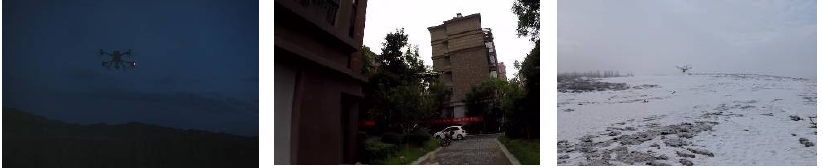
Figure 1. Some samples of challenges related to the resemblance of drones and birds.